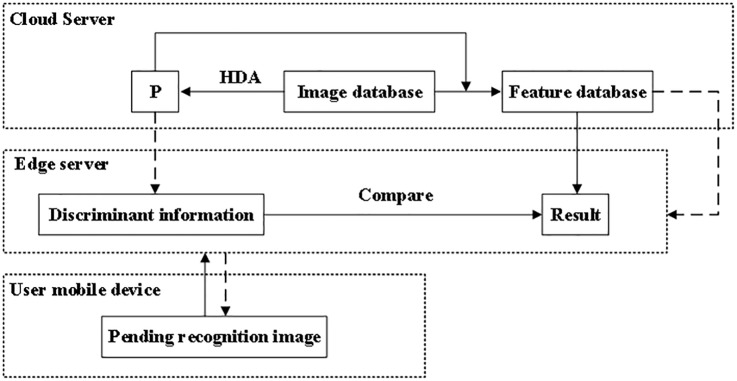
Application architecture of image recognition optimization algorithm under MEC environment.